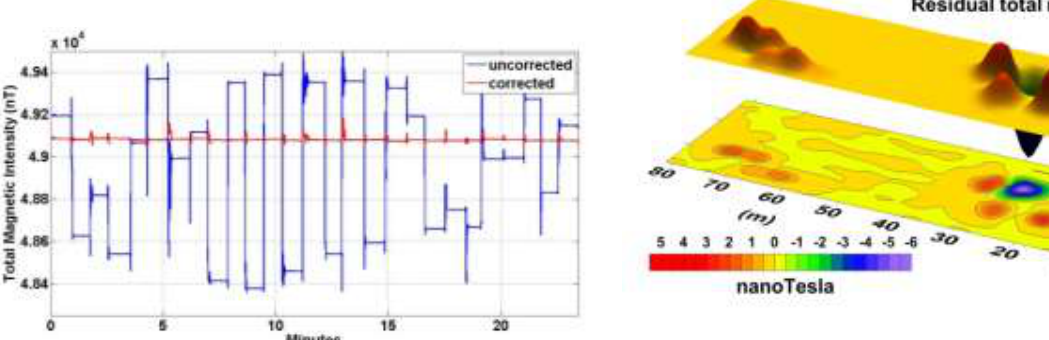
Figure Coil system to calibrate fluxgate magnetometer.